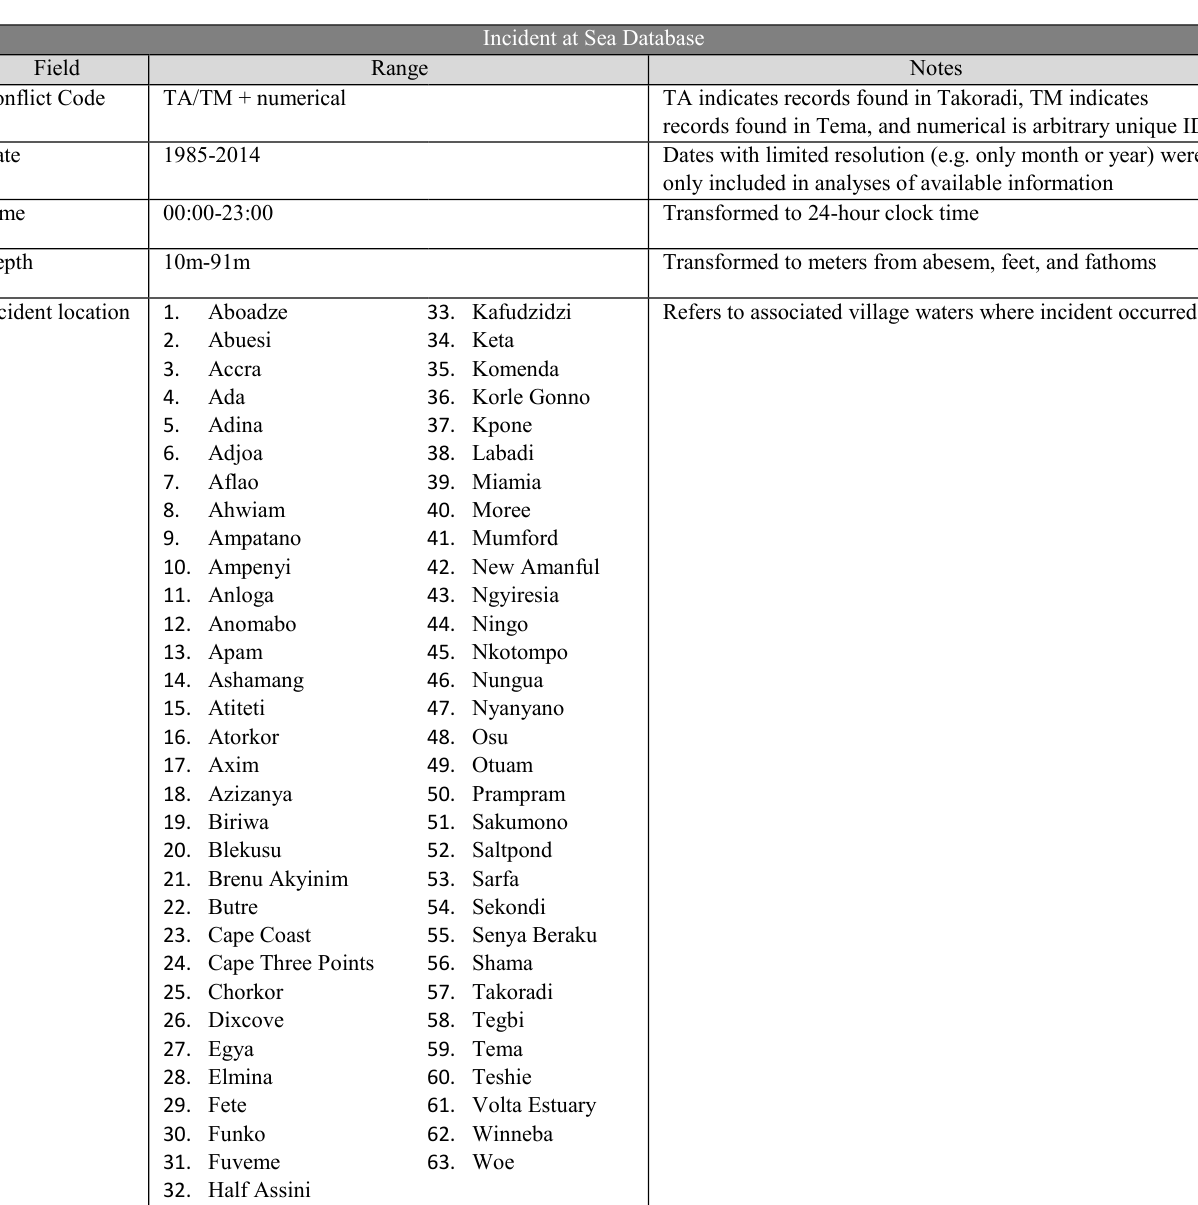
Table A1.1 : Coded data from Incident at sea